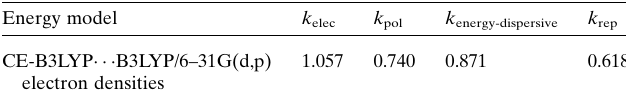
Table 2 Scale factors for benchmarked energy